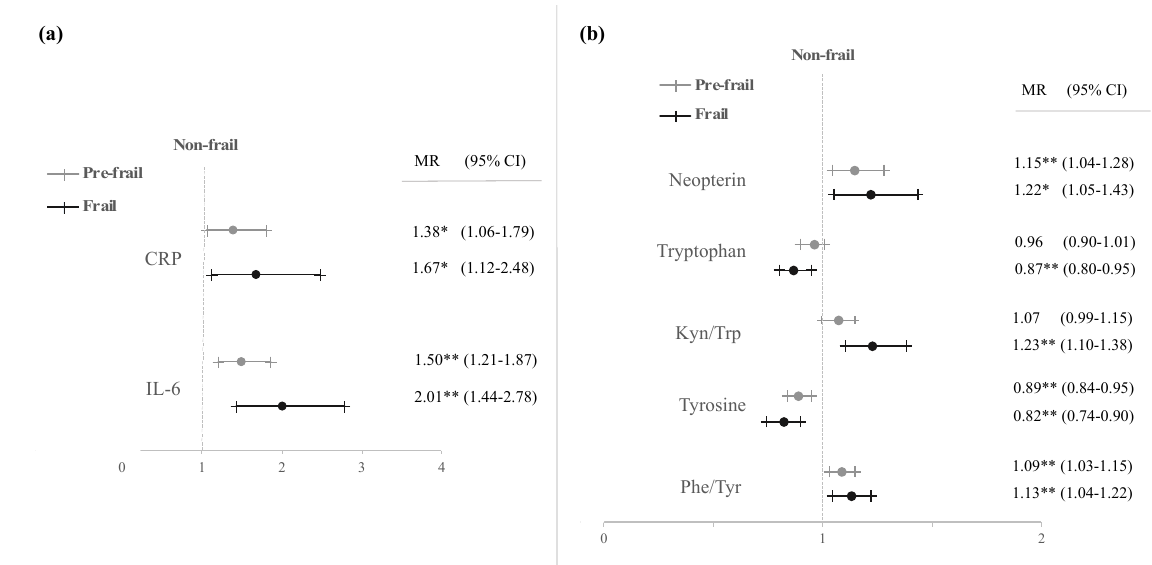
Figure 1. Adjusted mean ratios (MR) with 95% confidence interval (CI) of inflammatory biomarkers ( a ) and immune activation parameters ( b ) in pre-frail and frail subjects. Models adjusted by age, gender, smoking habits, and actual confounders. * p < 0.05; ** p < 0.01.